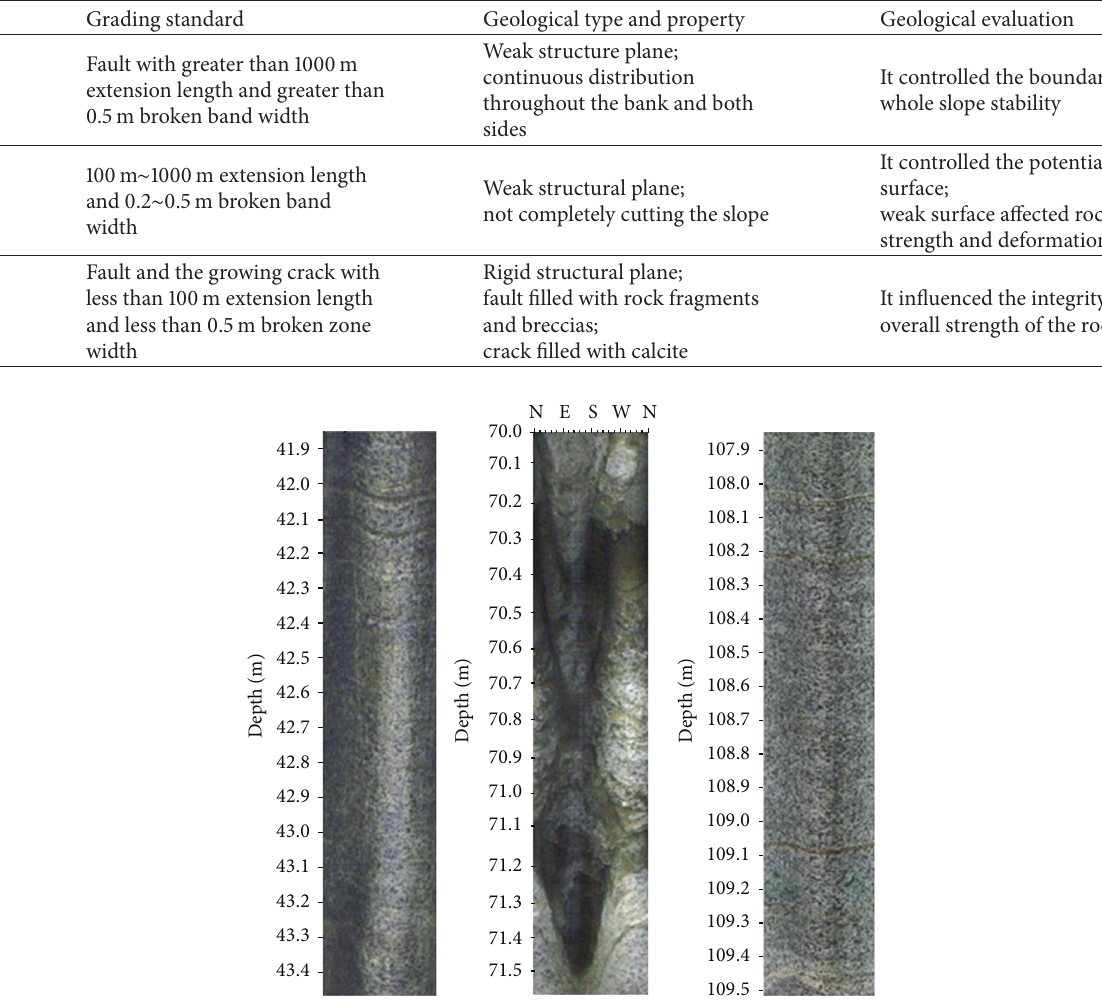
Figure 5: Rock structure characteristics in different drilling